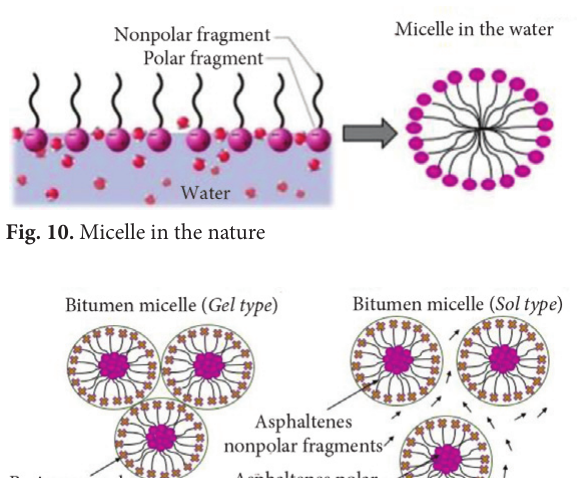
fig. 9. Recommended bitumen fractional composition from the experimental research